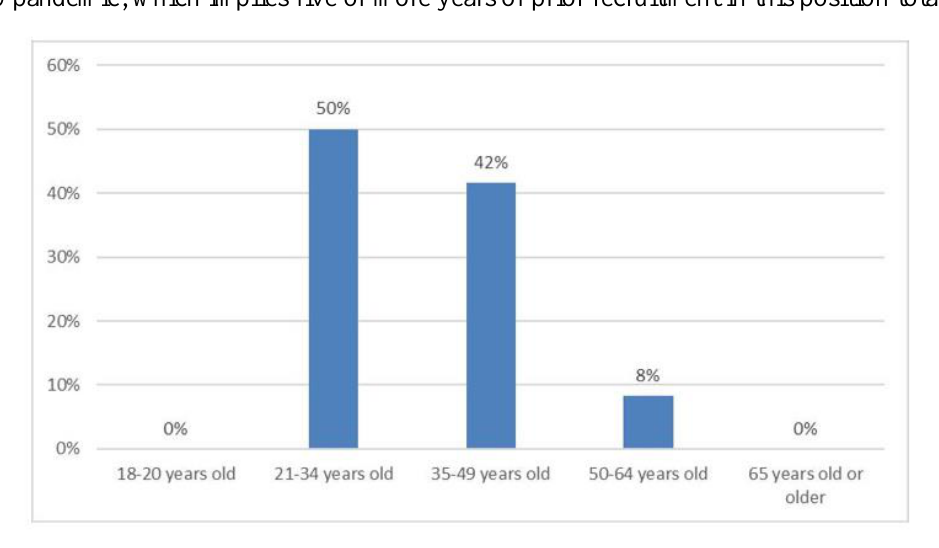
Figure 6. What is Your Age? (%)